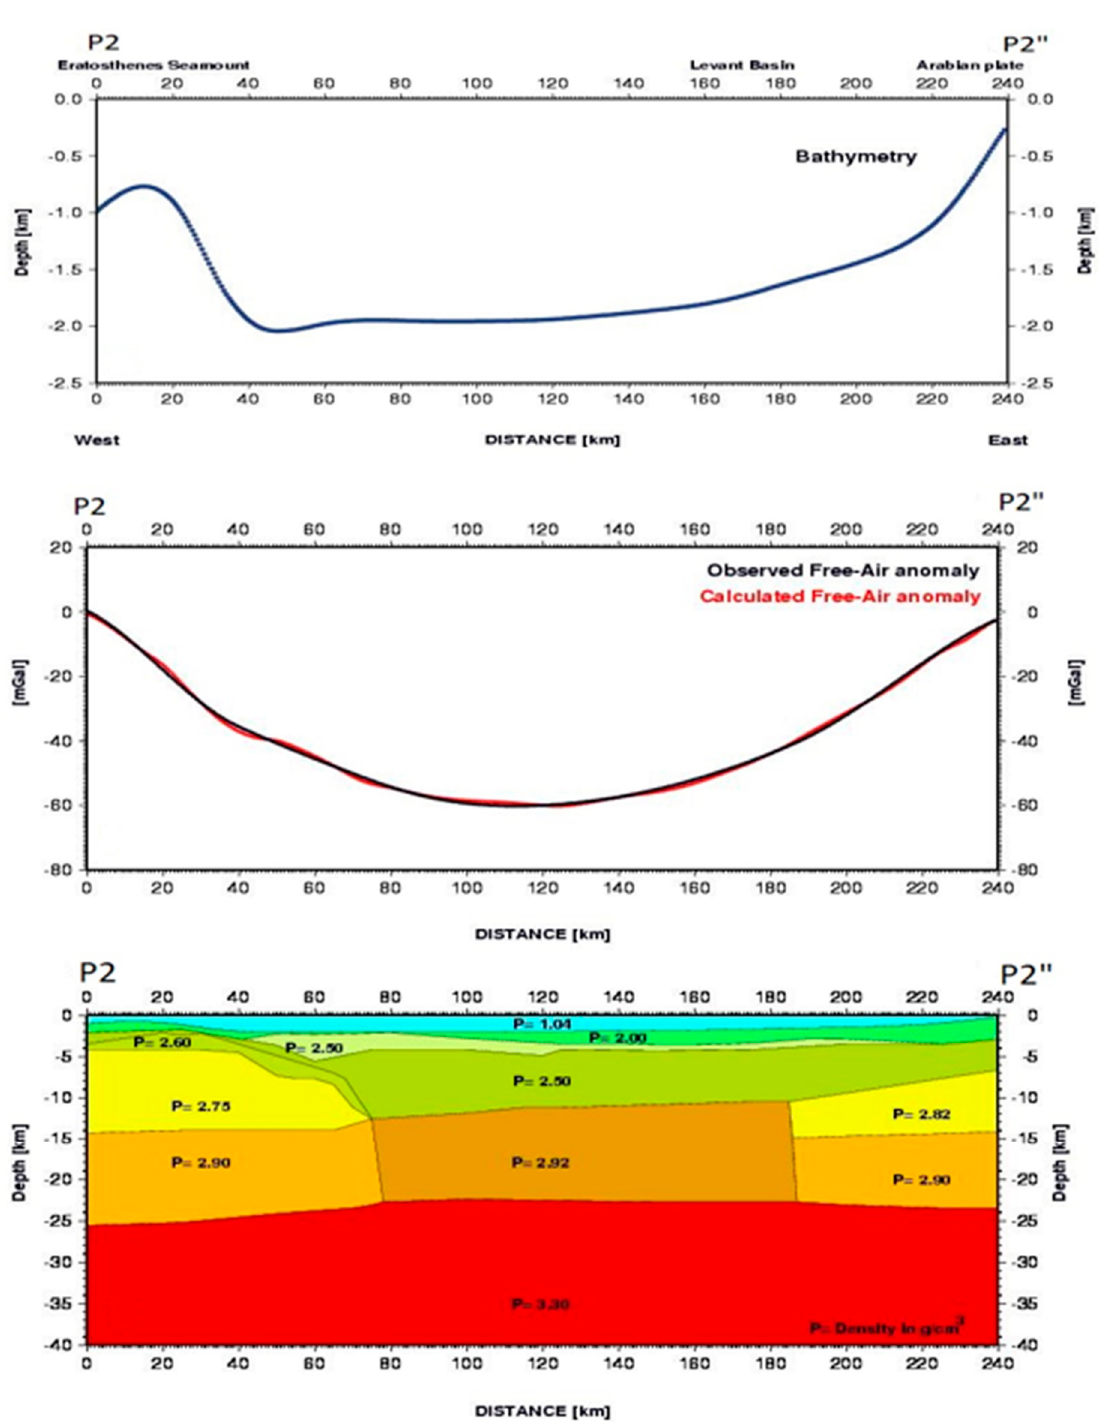
Figure 5. 2D modelling gravity along profile P2–P2 ″ .